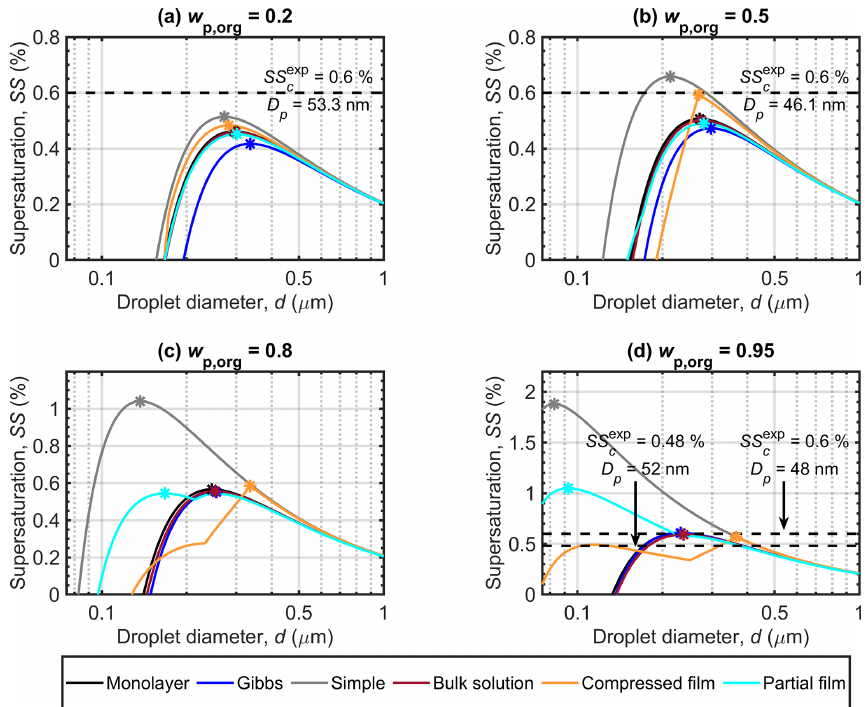
Figure 2. Köhler curves calculated with the different models for dry malonic acid–ammonium sulfate particles with D p = 50nm. Each panel shows curves for particles with a different malonic acid mass fraction ( w p , org ). The critical points are marked on each curve. Experimental critical supersaturations reported by Abbatt et al. (2005) in panels (a) and (b) corresponding to w p , org = 0 . 3270 and 0.5556, respectively, and by Giebl et al. (2002) for the values on the left, corresponding to the bottom dashed line, as well as by Rissman et al. (2007; fitted to the original measurements by Kumar et al., 2003) for the values on the right corresponding to the top dashed line in panel (d) both for pure malonic acid particles (corresponding to w p , org = 1), are also included. Note that the vertical axis scaling changes between the